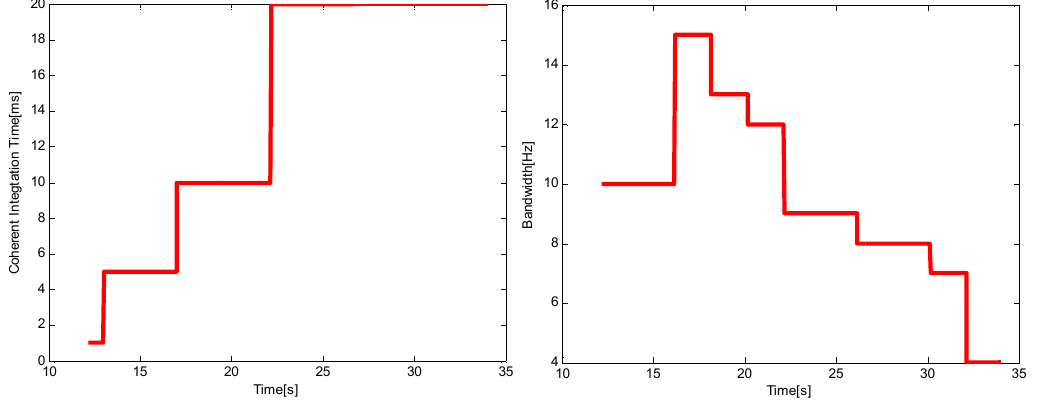
Figure 12. The choices of T ( left ) and B n ( right ) when p = 50 m/s 3 .